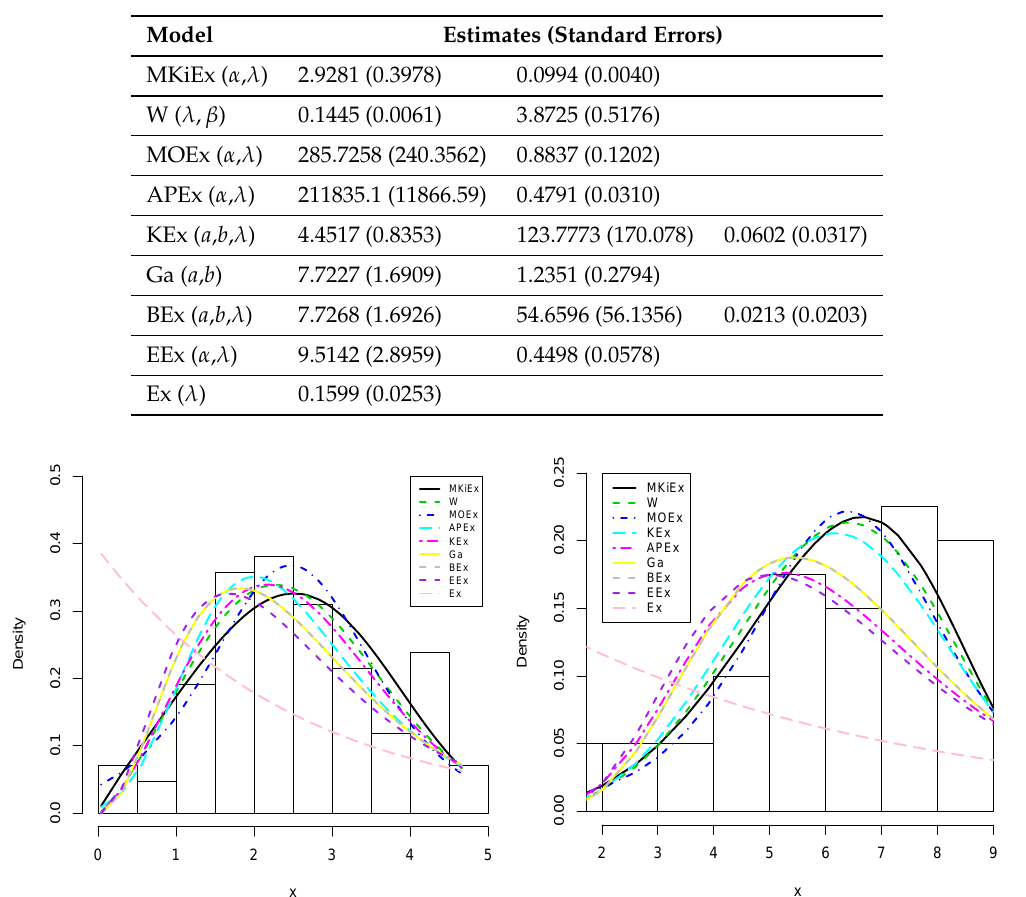
Table 8. Parameter estimates and standard errors for data set II.